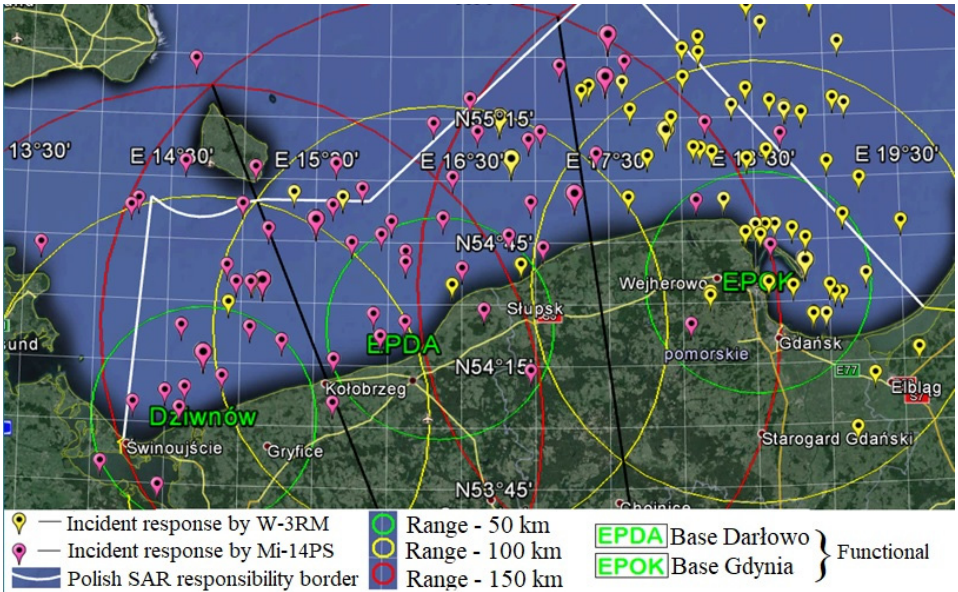
Figure 5. Range of operation of active SAR bases in Polish System (EPDA and EPOK) with provi- sionary base in